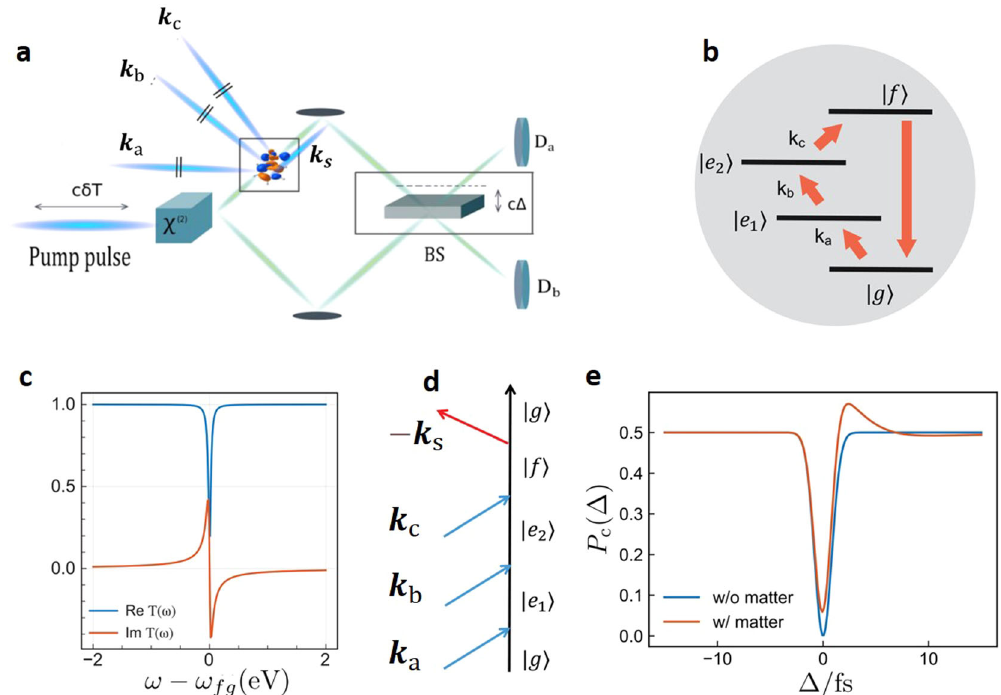
Fig. 2 Hong-Ou-Mandel (HOM) interference signal. An illustration of the variation of the coincidence probability with the optical delay Δ . a Level scheme of the model system. b Experimental setup based on HOM interferometer combined with four-wave mixing signal. c Its transmission function T ð ω Þ (cid:2) χ ð 3 Þ ð ω Þ (real part — orange line, imaginary part — blue line) Vs the scanned frequency ω 1 (cid:3) iA 0 level system is computed following ref. 9 . d Schematic diagram representing the main contribution of the third-order susceptibility. e Variation of the HOM coincidence counting rates with the optical delay (without matter — blue line, with matter — orange line).